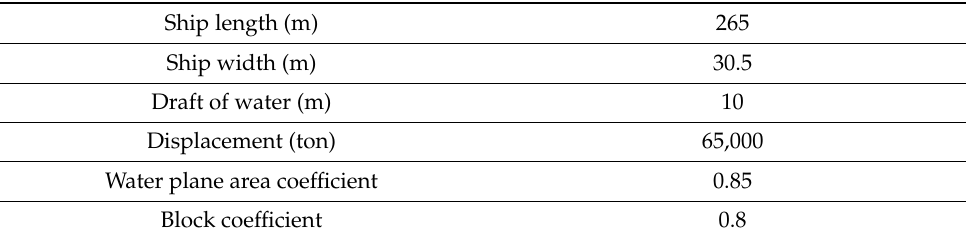
Table 3. The relevant simulation parameters of rolling, pitching and up and down